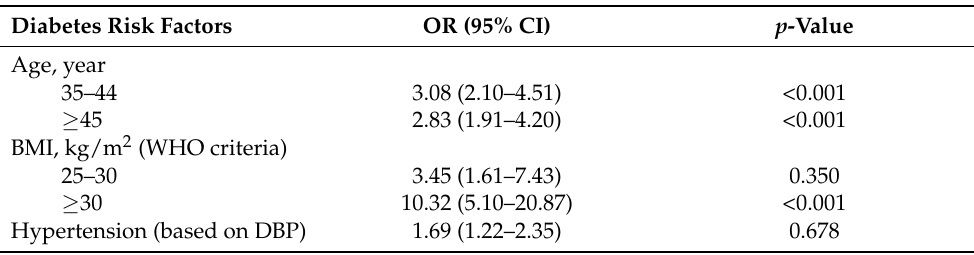
Table 5. US-PIMA Indian adults’ diabetes score in the US-PIMA Indian diabetes dataset (268 diabetes cases, n = 768, AUC = 0.79).